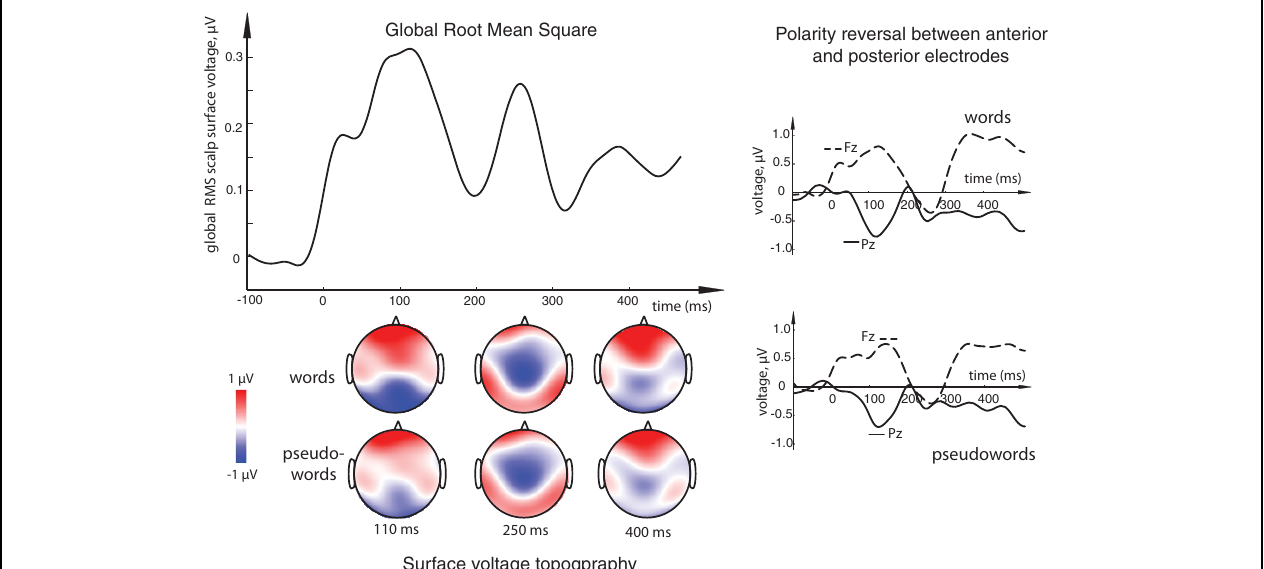
used for statistical comparisons. (Bottom left) Surface voltage topography of word and pseudoword ERPs at the three main peaks. (Right) Examples of ERP responses at single electrodes showing the opposite polarity at frontal (Fz) and posterior (Pz) sites. Timecourse of activity elicited by the orthographic stimuli is shown here after it has been subtracted by that in the visual sensory baseline control condition containing no orthographic oddball